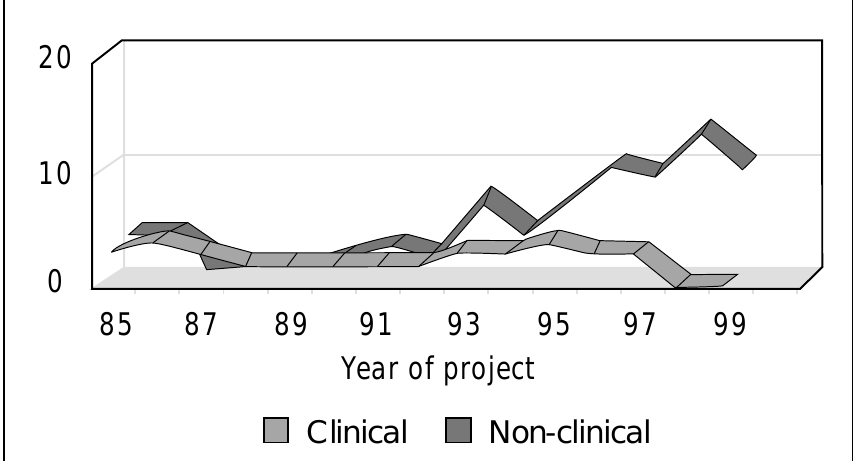
Figure 3: Comparison between clinical and non-clinical research projects